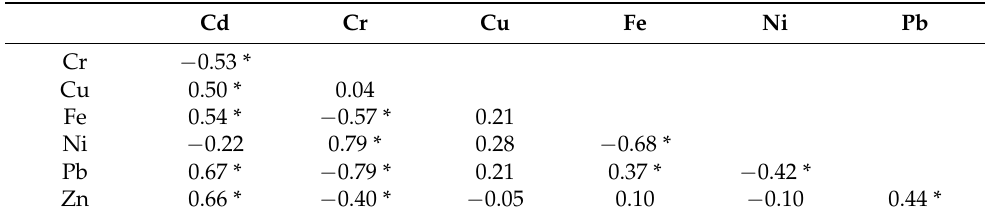
Figure 1. Dendrogram of raw materials and temperatures obtained from HCA. Table 3. Correlation coefficients between heavy metal contents.